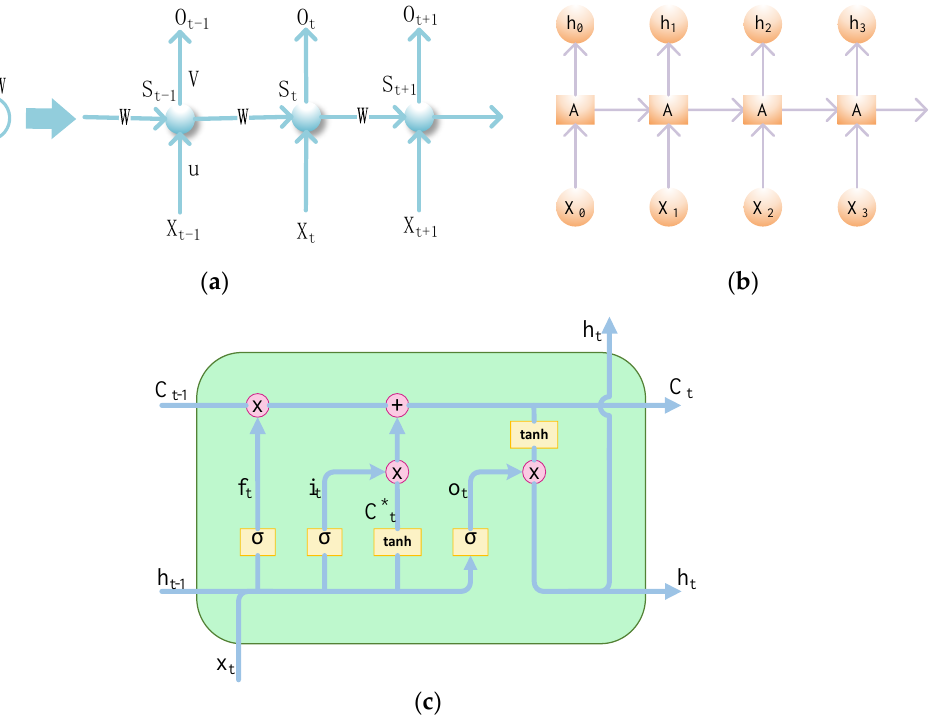
Figure 8. ( a ) Circulatory structure; ( b ) Basic structure of RNN; ( c ) Basic structure of LSTM. Among them, the input of the hidden layer processing unit S t includes X t , S t − 1 , X t is the input at the current moment, and S t − 1 is the information at the previous moment. After receiving the input, the tanh activation function should be used to map, and O t is the output at time t . Softmax is often used as an activation function. RNN is formed by stacking loop bodies. As shown in Figure 8b, it is a one-way RNN, which usually processes data related to the current moment and the previous